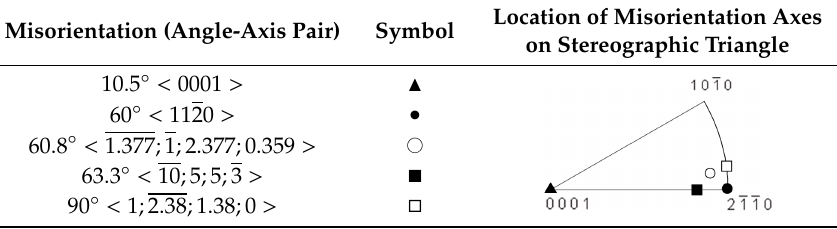
Figure S2: EBSD characterization of the base material: (a) low-resolution orientation (inverse-pole-figure) map, and (b) (0001) and {11-20} pole figures showing the texture. In (a), LABs and HABs are depicted as white and black lines, respectively. Figure S3: EBSD characterization of the base material: (a) high-resolution orientation (inverse-pole-figure) map, and (b) misorientation distribution. In (a), LABs and HABs are depicted as white and black lines, respectively. In (b), the insert in the top right corner shows misorientation-axis distribution. Figure S4: SEM micrograph taken from the stir zone that exemplifies several secondary-alpha colonies within a prior- β